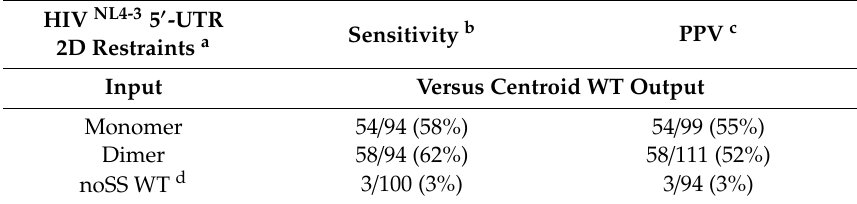
Table 2. Input restraints strongly influence positive predictive value of